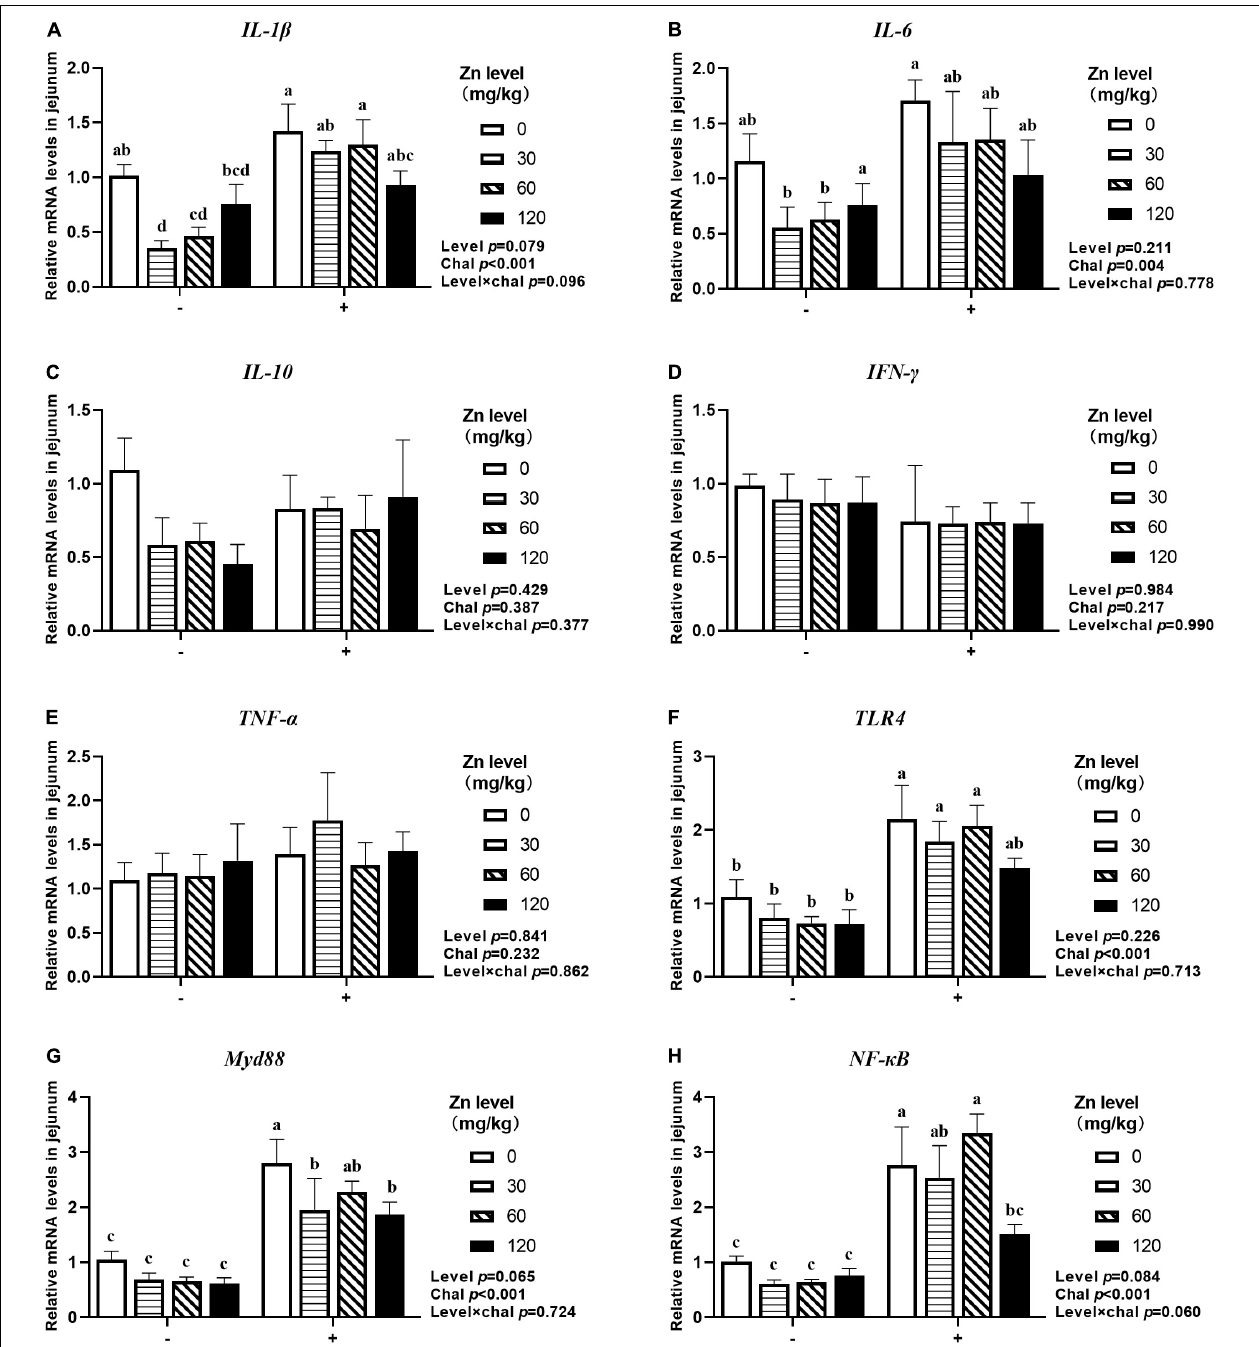
FIGURE 5 | Effect of dietary Zn–Met levels on the mRNA expression of inflammatory cytokines IL-1 β (A) , IL-6 (B) , IL-10 (C) , IFN- γ (D) , TNF- α (E) and TLR4 signaling pathway related gene (F–H) in jejunum of meat duck challenged with APEC (2 DPI). Bars with different letters are statistically significant ( P < 0.05). Results are expressed as mean ± SEM ( n =